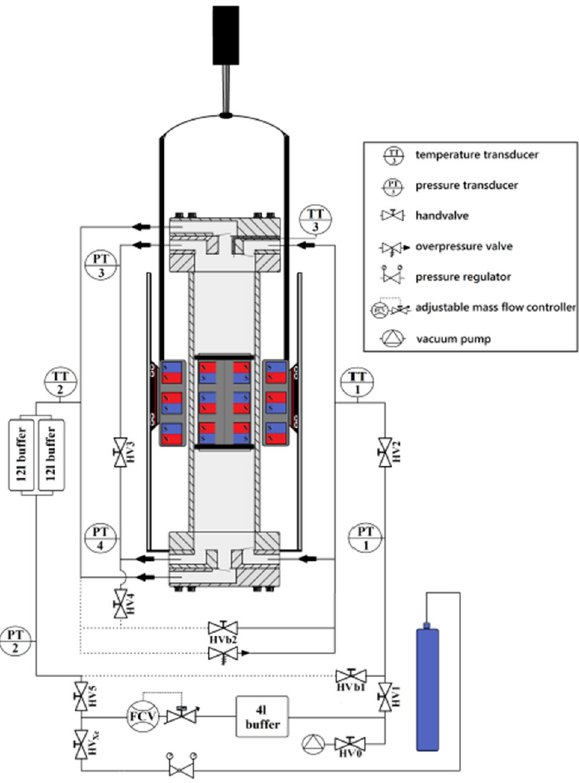
Fig. 12 Flow chart of the pump at Muenster pump test station. The black arrows indicate the unidirectional flow through the flapper valves. The red and blue color of the different magnets indicate their axial polarities